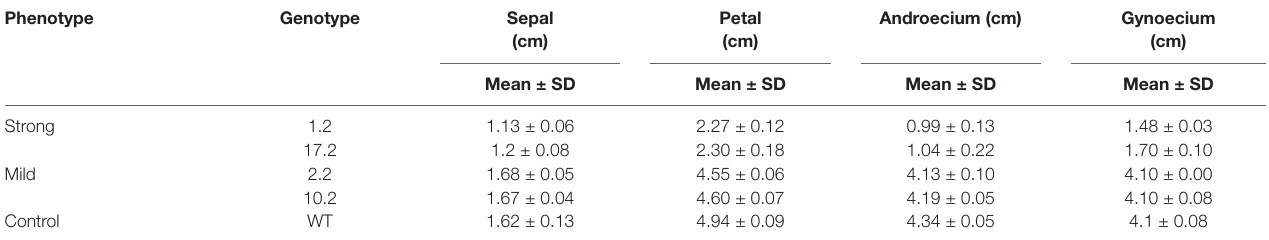
TABLE 1 | Analysis of the length of different floral organs in transgenic tobacco plants overexpressing the peach MYB10.1 compared with WT.